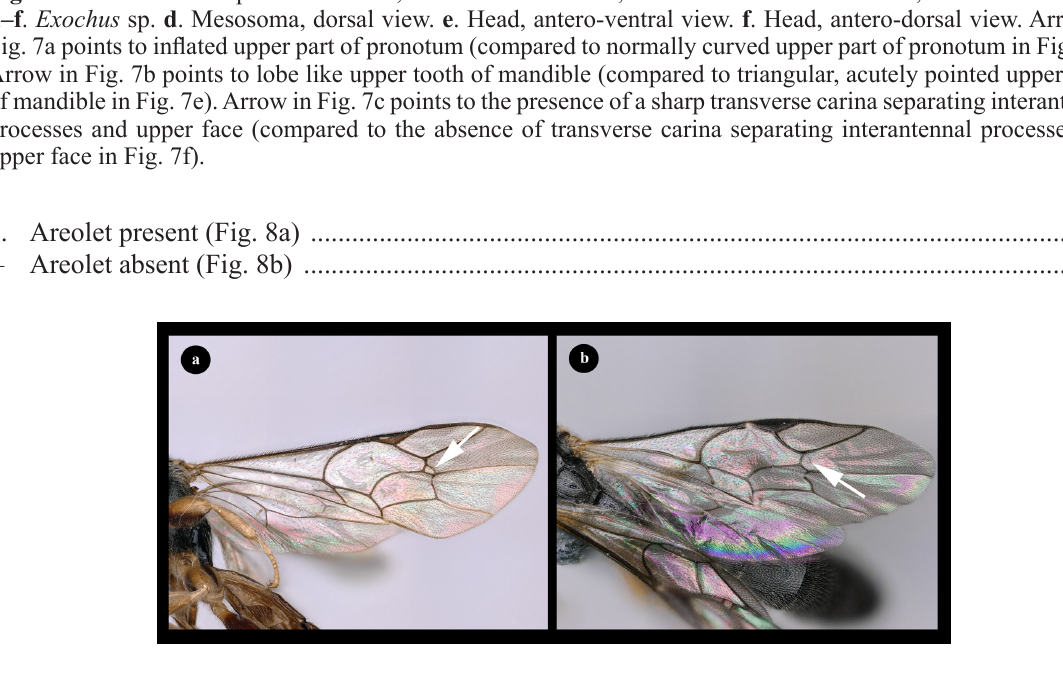
Fig. 8. a . Colpotrochia sp., fore wing. b . Trieces orientalis Ranjith & Priyadarsanan, 2022, fore wing. Arrow in Fig. 8a points to fore wing with areolet (compared to fore wing without areolet in Fig.